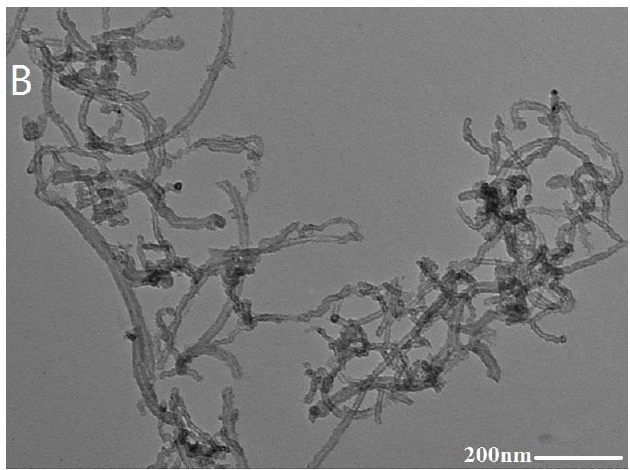
Figure 4. TEM images of MWCNTs ( A ) and carboxyl MWCNTs ( B ).